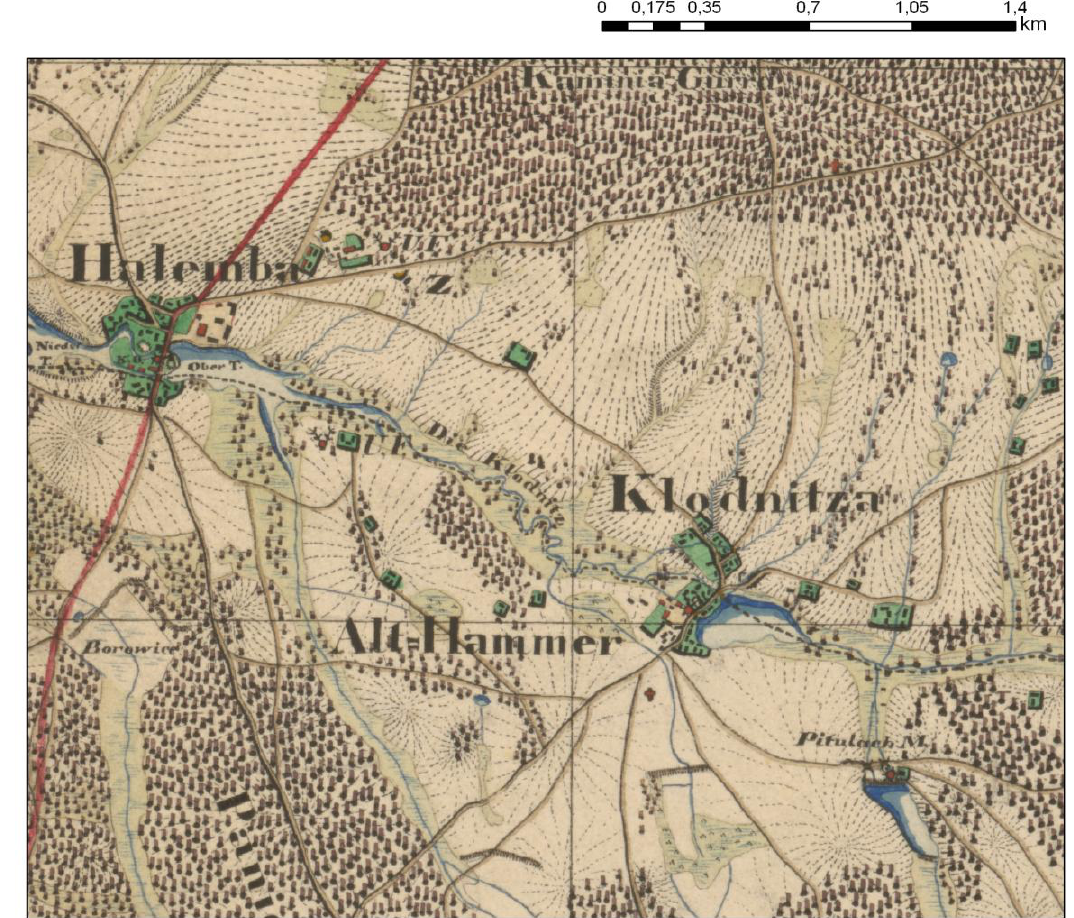
Fig. 3. Fragments of Urmesstischblatt, sheet Swietochowitz no. 3353, draw-up year